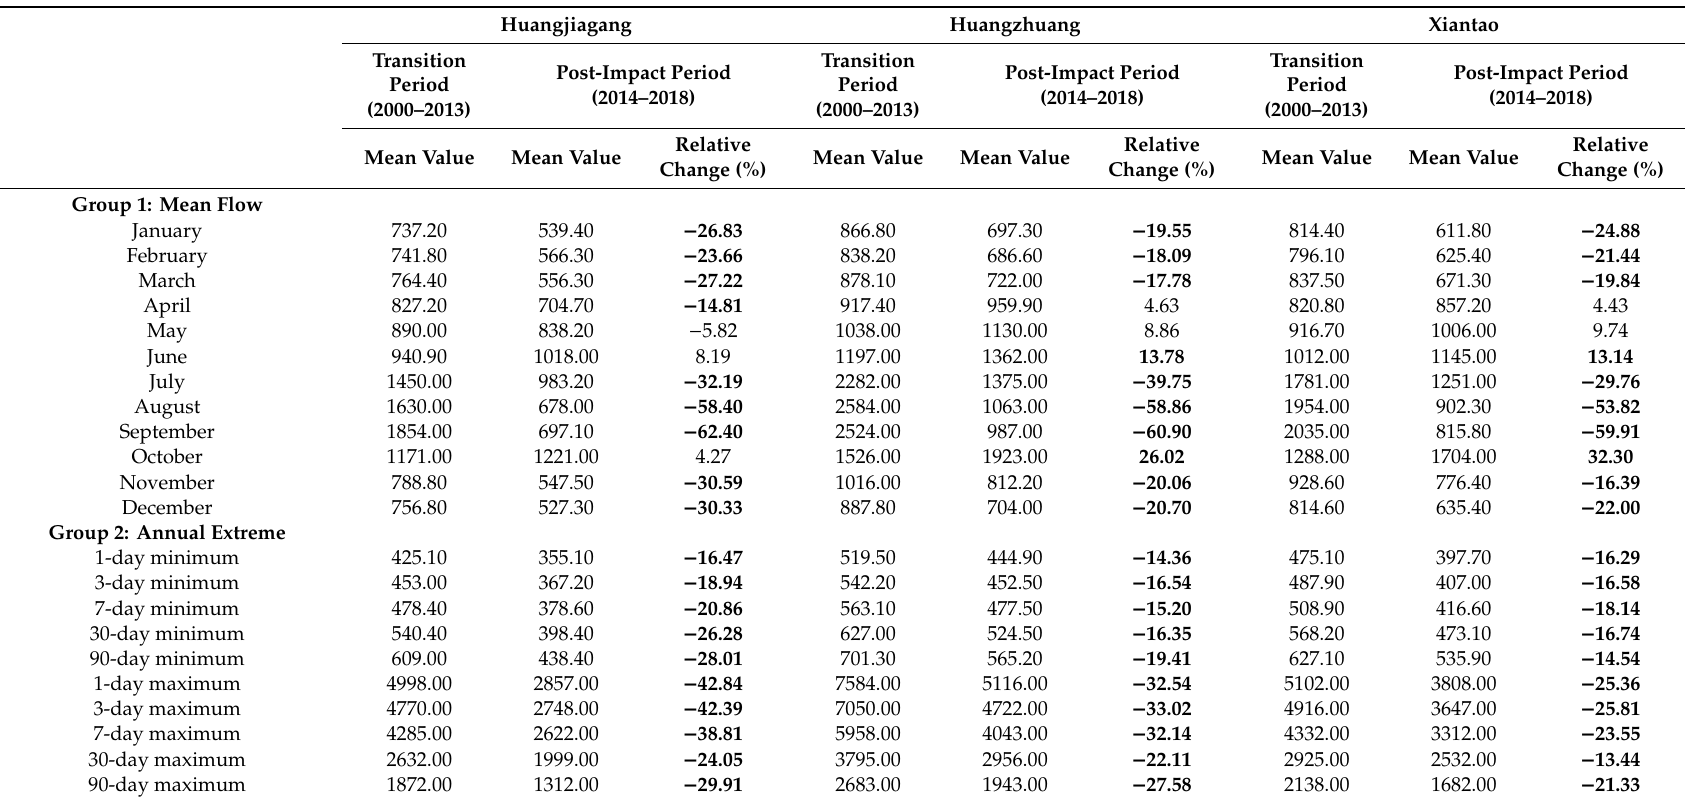
Table 5. Changes of IHA metrics in the post-impact